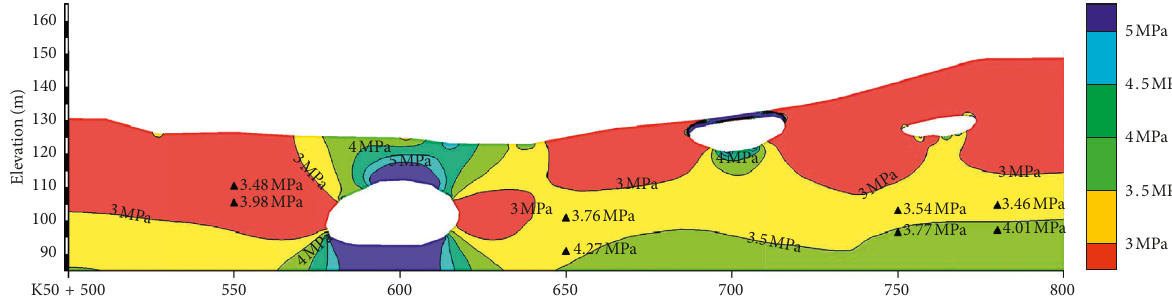
Figure 15: Simulation of the in situ stress.